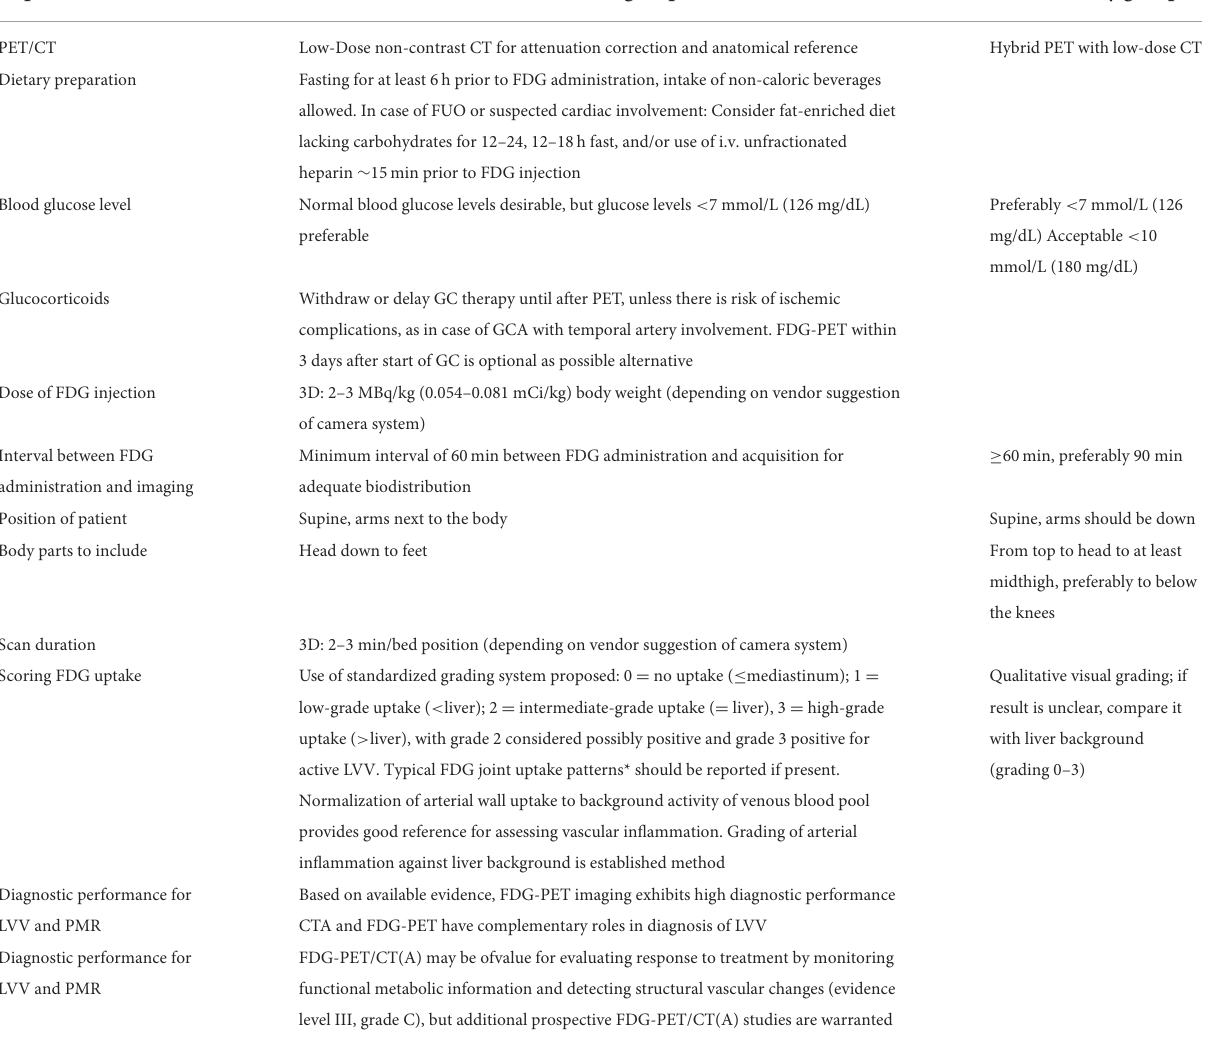
TABLE 1 Summary of 2018 recommendations for FDG-PET/CT(A) imaging in large vessel vasculitis and polymyalgia rheumatica by (a) the EANM, SNMMI, and the PET Interest Group (PIG), endorsed by the ASNC (10) and (b) a EULAR study group (11). Topic EANM, SNMMI, and PET interest group EULAR study group